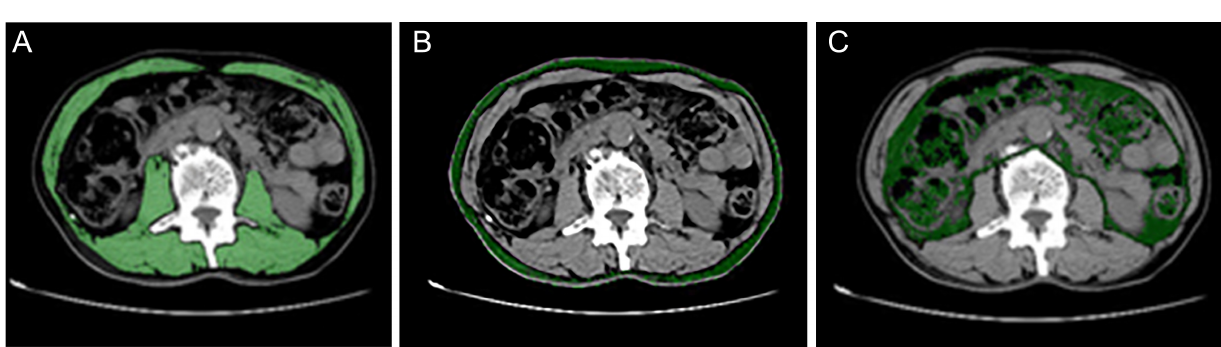
Figure 1. Skeletal muscle area measurement range ( − 30 to 150 HU). (A), SFA measurement range ( − 190 to − 30 HU) (B), and VFA measurement range ( − 190 to − 30 HU), (C) show body composition measurement on abdominal CT (at the level of the third lumbar vertebra). SFA, subcutaneous fat area; VFA, visceral fat area; CT, computed tomography; HU, Hounsfield